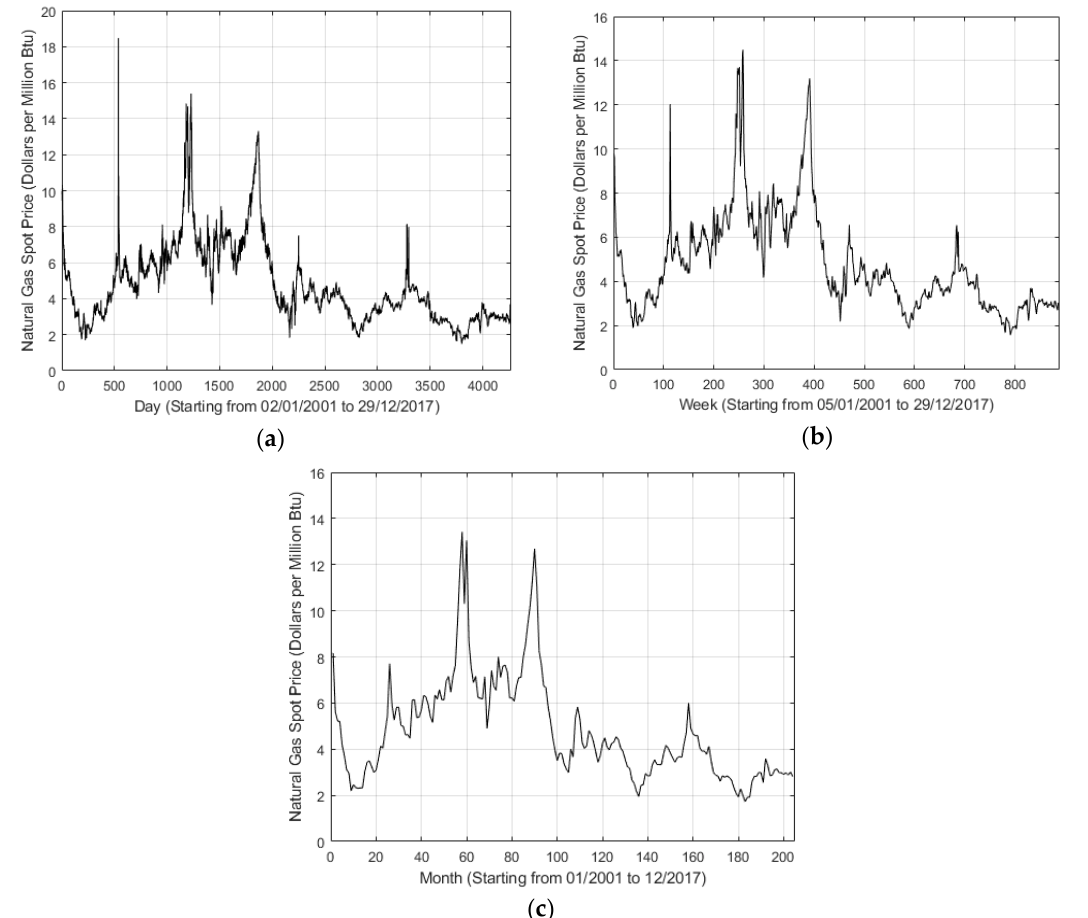
Figure 1. Henry Hub natural gas spot price series data of different timescales. ( a ) Daily, ( b ) Weekly, ( c ) Monthly. Table 1. Summary of descriptive statistics of natural gas spot price series for different timescales. Timescale Mean